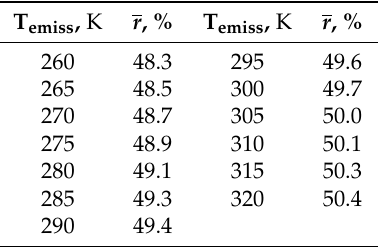
Table 5. Planck weighted mean spectral dome transmittance r for a suite of common T surf . T emiss , K r , % T emiss , K r , % 260 48.3